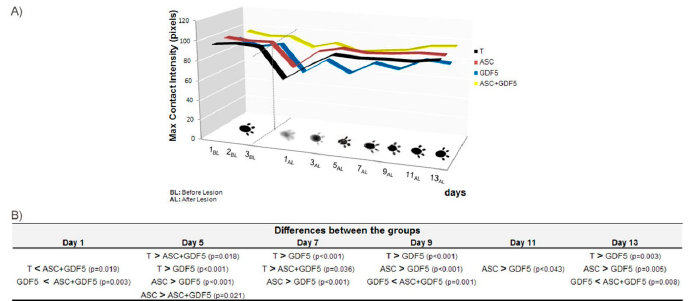
Figure 8. ( A ) Maximum contact intensity of the paw of the animals during walking, obtained through the CatWalk system. The measurements were taken three days before the injury to obtain the normal walk pattern, and on the 1st, 3rd, 5th, 7th, 9th, 11th, and 13th days after the tendon transection. Observe the marked decrease in contact pressure of the animals’ paw on the day after surgery, with a higher value of the ASC+GDF5 group compared to the T group. Except for the GDF5 group, observe the complete recovery of the normal walk pattern of the animals in the other groups on the 13th day. ( B ) Comparisons between groups with significant differences observed between the 1st and 13th